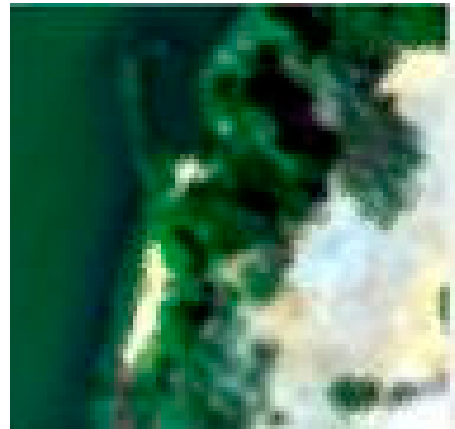
Figure 13. Subimage of Samson hyperspectral dataset. Table 9. SAD results on the Samson data.